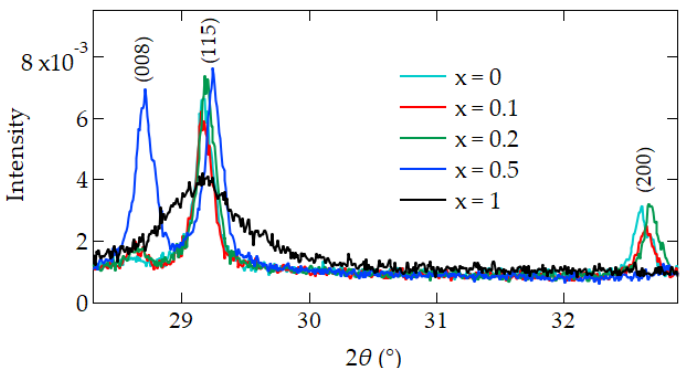
Figure 7. X-ray diffraction (XRD) profiles of C x S 1–x BT with ( a ) x = 0; ( b ) x = 0.1; ( c ) x = 0.2 ( d ) x = 0.5; and ( e ) x = 1. The intensities were normalized to the Si (400) peak intensity. Modified from [19].